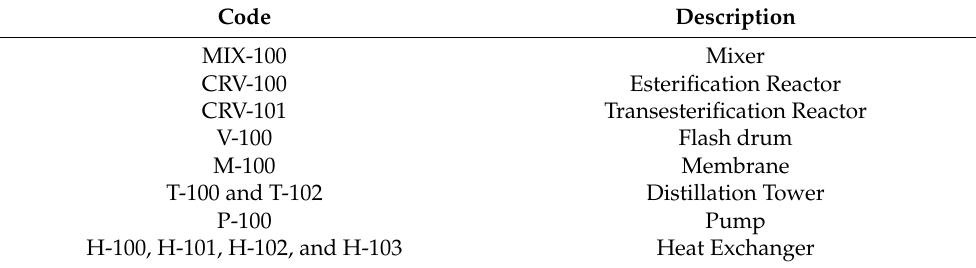
Table 5. Equipment description of the simulation flowsheet using Aspen Hysys